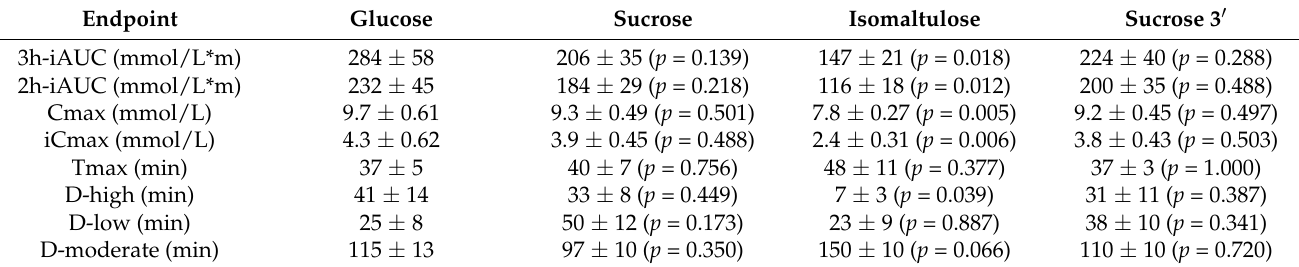
Table 2. Descriptive statistics (mean ± SE, N = 11) for the three beverages featuring 50 g sugar dissolved in 125 mL semi-skimmed milk, and the intermittent sucrose beverage supply. For pairwise comparisons vs. glucose (paired t -test, two-sided), p -values are given in